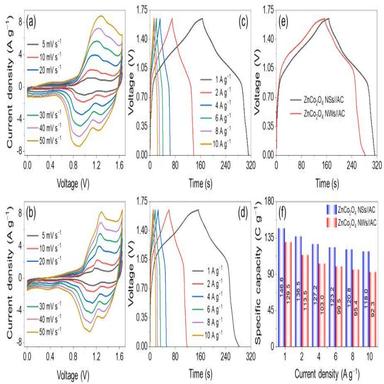
CV curves of (a) ZnCo2O4 NSs//AC HSC and (b) ZnCo2O4 NWs//AC HSC at different scan rates, GCD curves of (c) ZnCo2O4 NSs//AC HSC and (d) ZnCo2O4 NWs//AC HSC at different current densities, (e) GCD curves of the two HSCs at 1 A g− 1 , and (f) rate performance of the two HSCs.